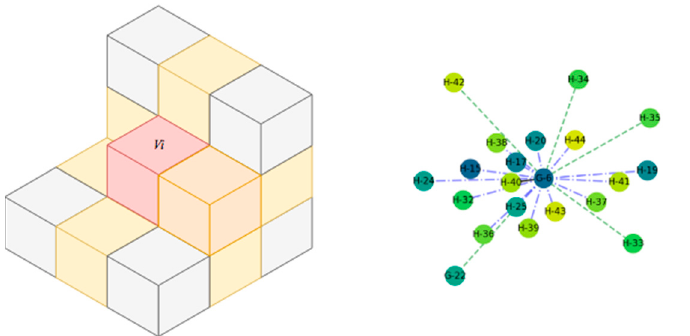
Figure 7: Direct voxel-to-voxel topology in a 26-connectivity graph. Considered voxel (cid:2288) (cid:3036) is red, Figure 7. Direct voxel-to-voxel topology in a 26-connectivity graph. Considered voxel V i is red, direct direct connections are either vertex.touch (grey), edge.touch (yellow), or face.touch (orange) connections are either vertex.touch (grey), edge.touch (yellow), or face.touch